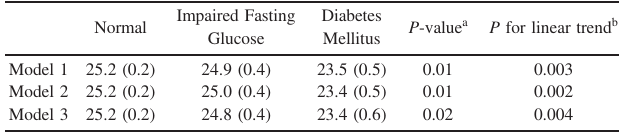
Table 2. Adjusted mean MoCA-J scores in 2018 according to fasting blood glucose levels at baseline,